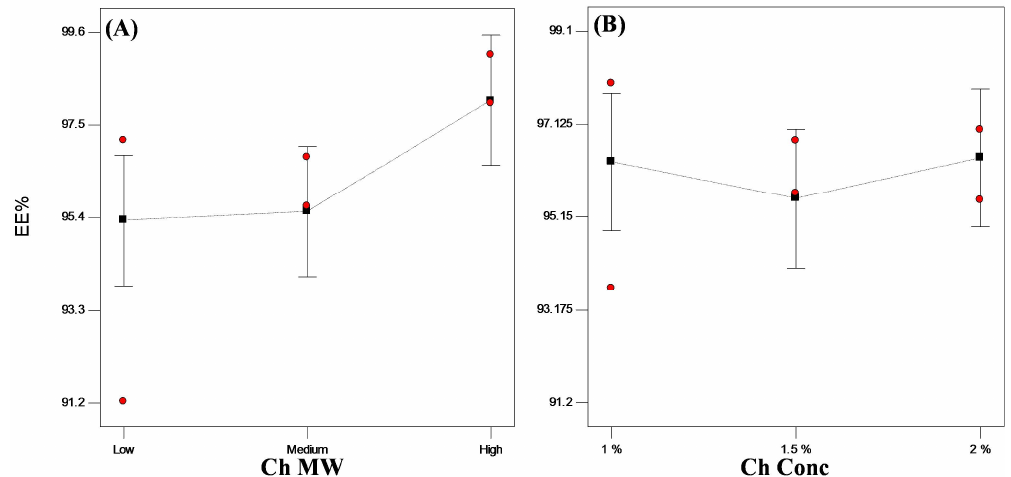
Figure 4. Line plot for the main effects of ( A ) Ch molecular weight (MW) and ( B ) Ch concentration on the encapsulation efficiency (EE%) of VP-loaded Ch-based beads.